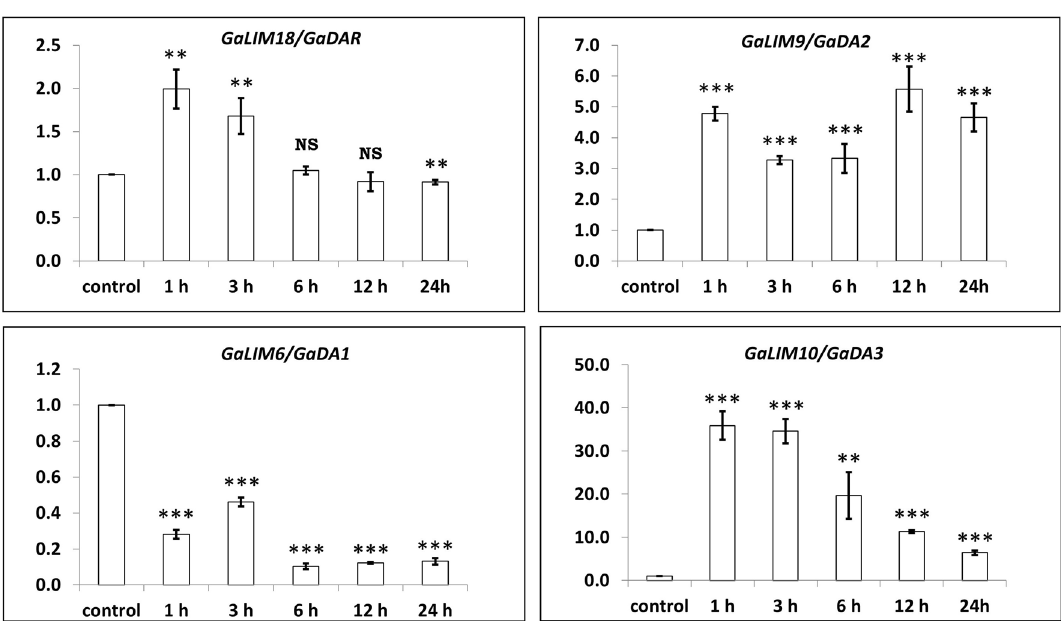
Figure 7. Relative expressions of plant-specific LIM family genes in response to challenge of Fusarium oxysporum . NB Relative gene expression levels are represented with respect to their expressions in mock treated control plants. Gene expression in control was used as calibrator (set to unit one). Data were normalized using the average expression levels of Ghactin4 as reference gene. Error bars represent standard deviation. Asterisk denotes significant differences (* P > 0.05, ** P > 0.01 and *** P > 0.001) compared to their respective controls; NS